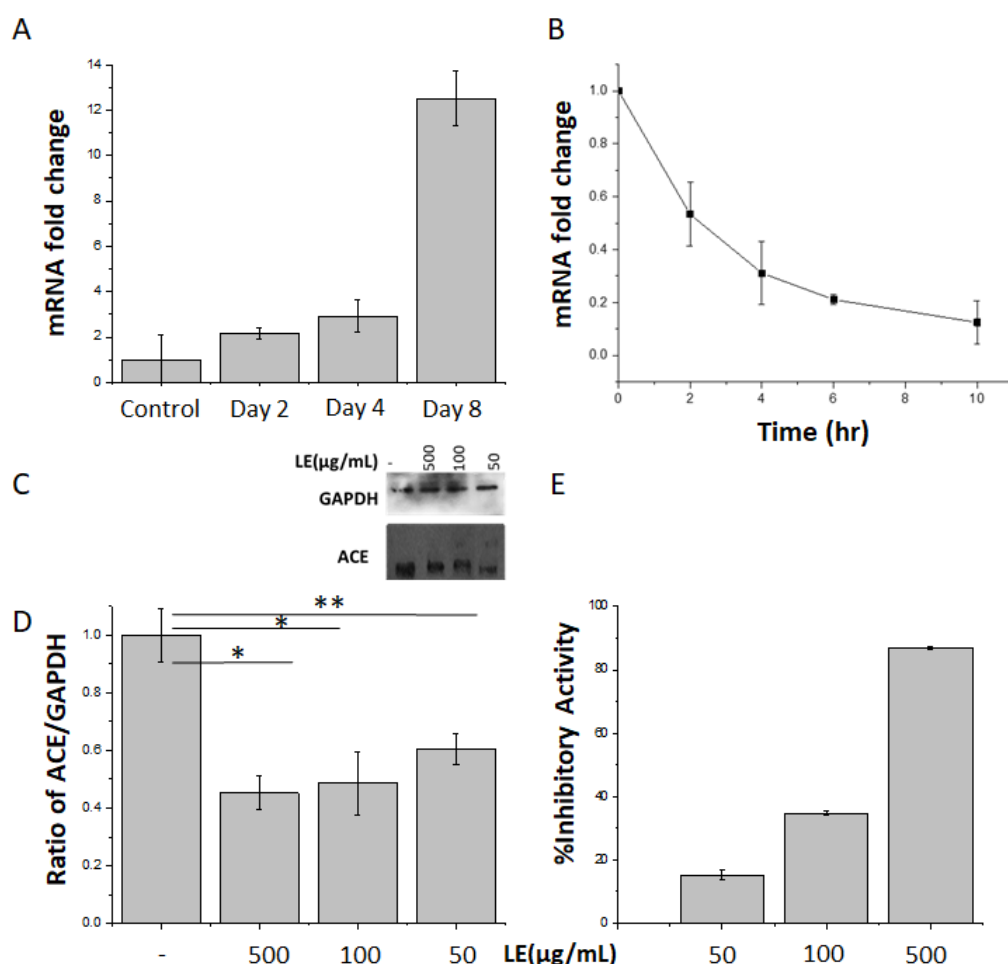
Figure 1. Total lemon extracts (LE) decrease angiotensin converting enzyme (ACE) expression and activity. ( A ) ACE mRNA expression levels were quantified at the indicated days during 3T3L1 adipocyte di ff erentiation. n = 3 independent experiments, p < 0.001. ( B ) Fully di ff erentiated 3T3L1 adipocytes were treated or not with LE (100 µ g / mL) for the indicated times and ACE mRNA expression levels were quantified. n = 3 experiments, p < 0.05. ( C ) 3T3L1 di ff erentiated adipocytes were incubated with 50, 100 or 500 µ g / mL of LE for 10 h on day 8. ACE and GAPDH protein expression were assessed by immunoblotting. GAPDH was used as internal control. n = 3. ( D ) Signal quantification of ACE and GAPDH immunoblots ( E ) LE inhibitory e ff ects on ACE activity. Cells were treated with LE (50, 100 and 500 µ g / mL) and conversion of Abz-GLY-PHe(NO2)-Pro to Abz-GLY was quantified as described in methods. n = 3. ** significant at p = 0.01 and * significant at p = 0.05.